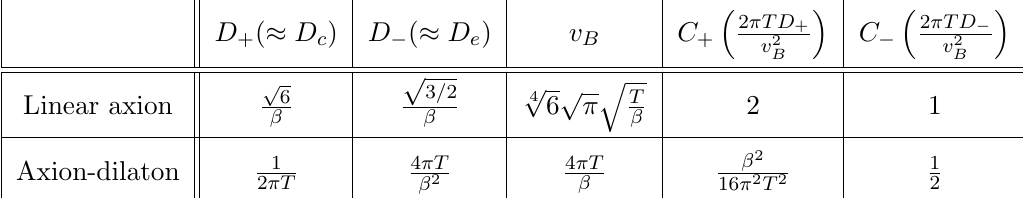
At (cid:12)nite density, the axion-dilaton model has two branches of solutions so we have to choose a ground state by comparing their grand